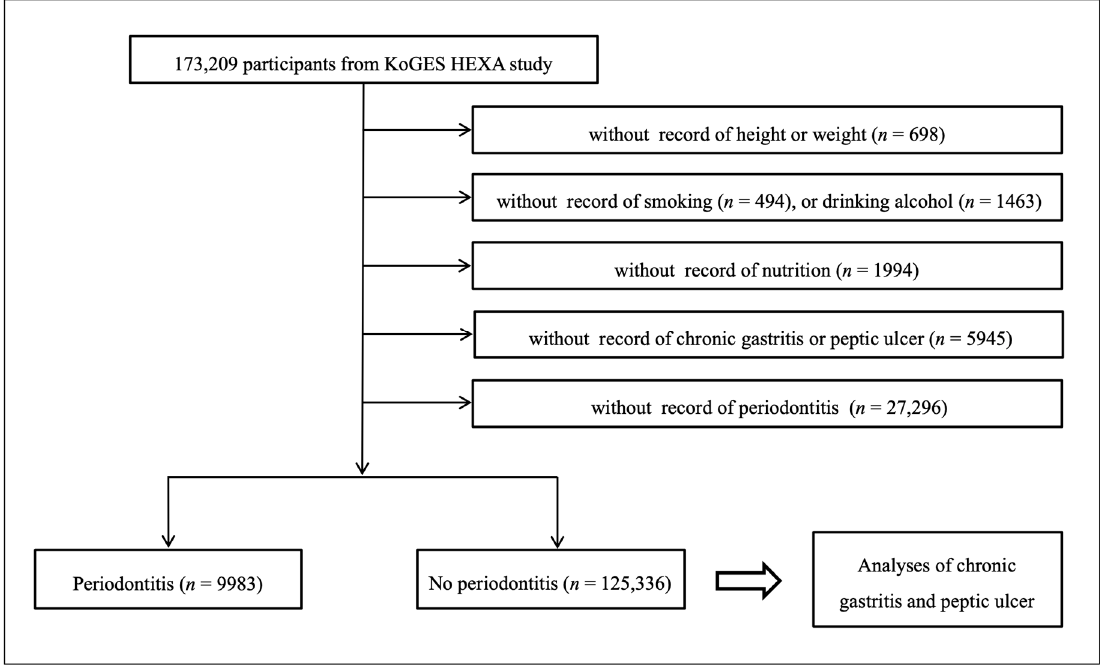
Figure 1. A schematic illustration of the participant selection process. Of a total of 173,209 participants, 9983 participants with periodontitis and 125,336 with no periodontitis were selected.